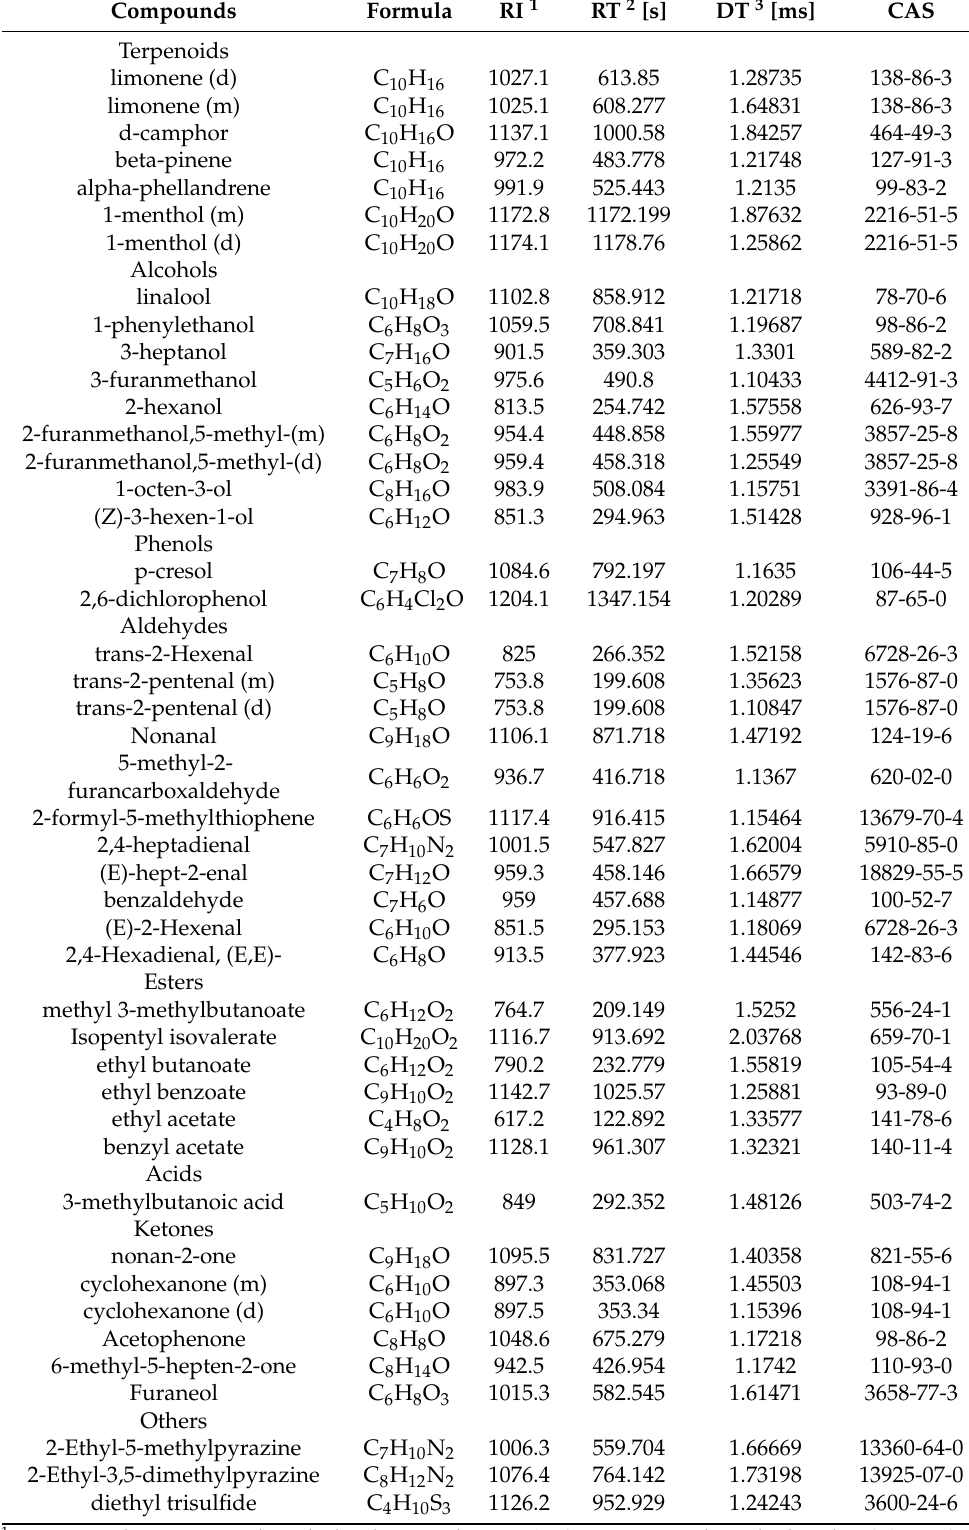
Table 1. Identification of the VOCs in SS by